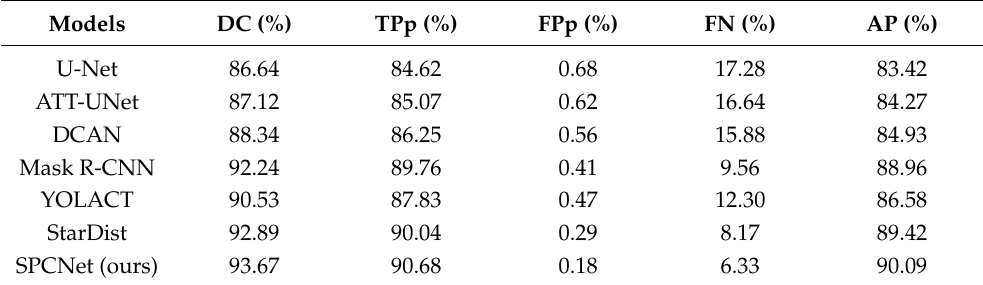
Figure 8. Segmentation results of our model on the EDF-ISBI test set, where the input images and their predictions are shown from top to bottom, respectively. Table 5. Performance comparison of our model and the classical segmentation models on the ALL- IDB